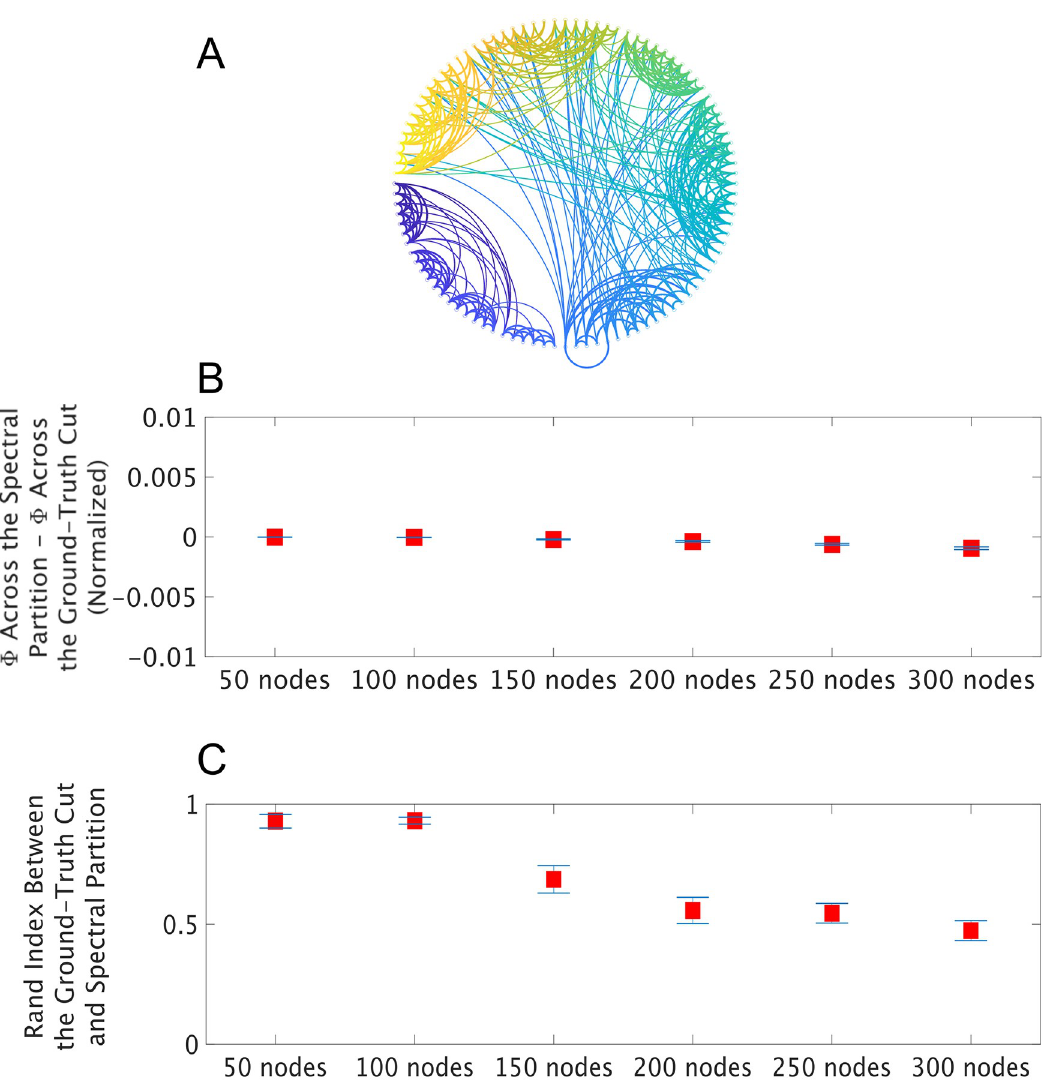
Fig 3. A Having shown that spectral clustering can find the MIB in time-series data from small networks, we next asked whether it could find the MIB of large simulated networks. While large networks cannot be exhaustively searched for their MIB, the MIB can be forced onto them by cutting them in half. We generated 40 such cut networks for each network size. Network sizes ranged from 50 nodes to 300 nodes. B Here, we show F G (normalized) across the ground-truth cut subtracted from F G (normalized) across the partition identified through spectral clustering. Red squares indicate the mean across 40 networks, the absolute value of which never exceeded 0.001 bits (normalized), and the blue bars indicate standard error of the mean. C Here, we show the mean and standard error of the Rand Index between the ground-truth cut and the spectral clustering-based partition of the correlation matrix estimated from each network. The Rand Index between the spectral partition and the ground-truth cut was greater than 0.8 (indicating high similarity) for the majority of networks of all network sizes, except for the 200- to 300-node networks. Despite this dip in Rand Index, spectral clustering still found partitions across which F G (normalized) was extremely close to F G (normalized) across the ground-truth cut in the 300-node networks ( A ), which suggests that in these networks, there was sometimes several possible partitions that minimized normalized integrated information. We found that spectral clustering performed even better (nearly perfectly) using the same networks but with autoregressive network dynamics (S8